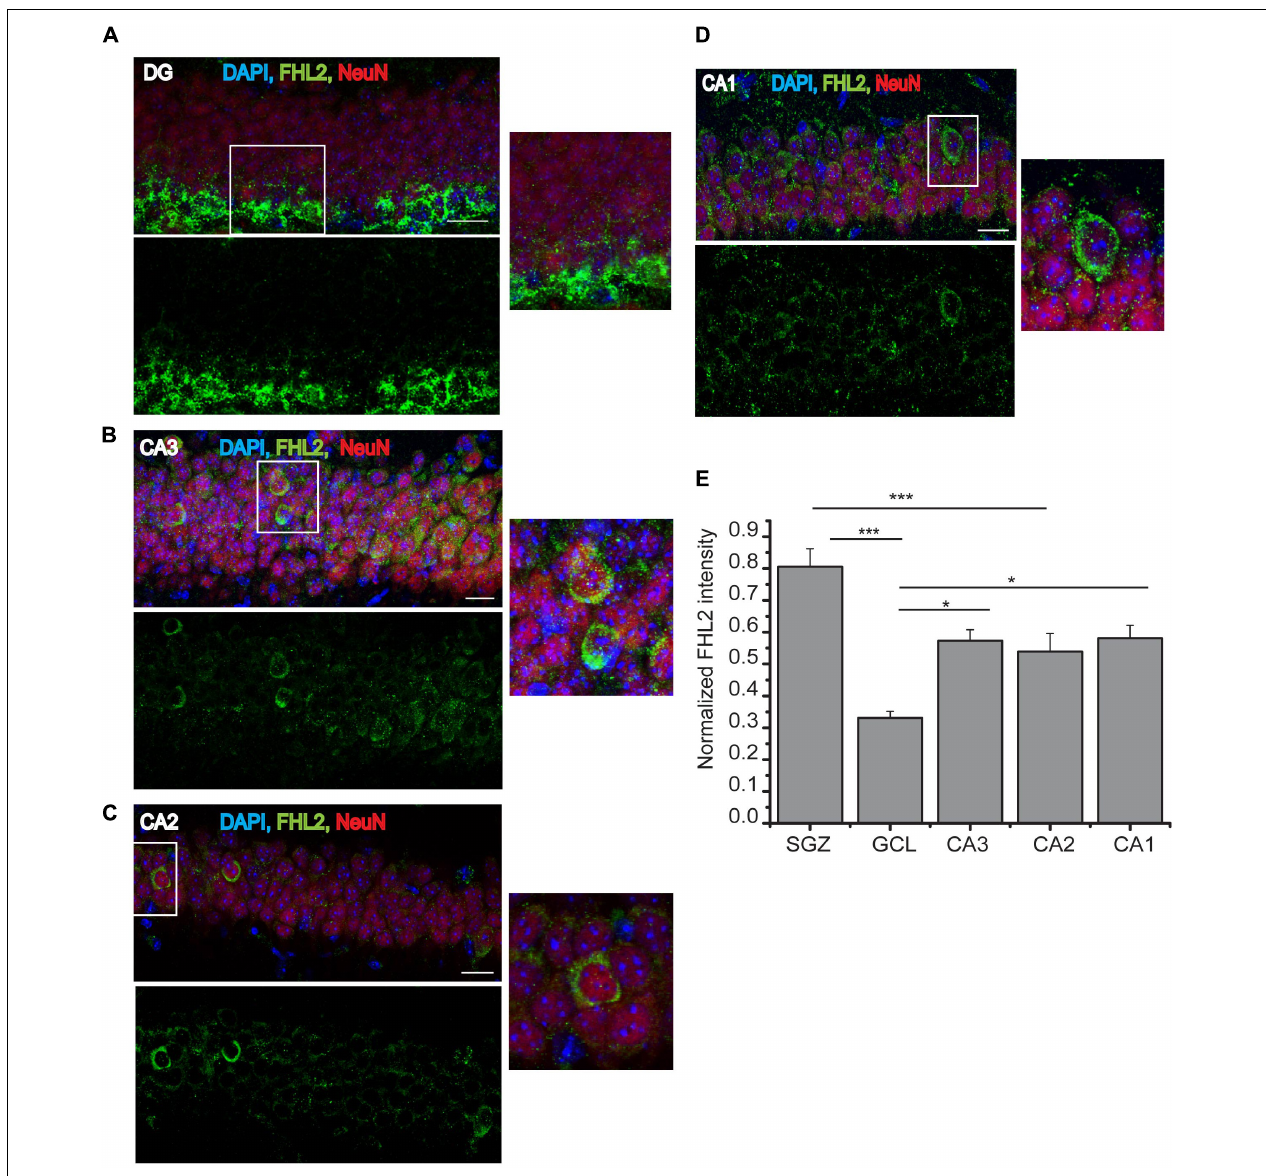
FIGURE 1 | Endogenous expression of FHL2 in the adult hippocampus. (A–D) Representative images of hippocampal subfields dentate gyrus (DG), CA3, CA2, and CA1 (respectively), immunolabeled for FHL2 and NeuN. (E) Quantification of normalized fluorescence of FHL2 throughout the hippocampus. One-way ANOVA F (3,156) = 5.69, P = 0.001. Scale bars, 10 µ m, N = 3 mice per condition. Data are presented as mean ± SEM. *** p < 0.001 and **** p < 0.0001.